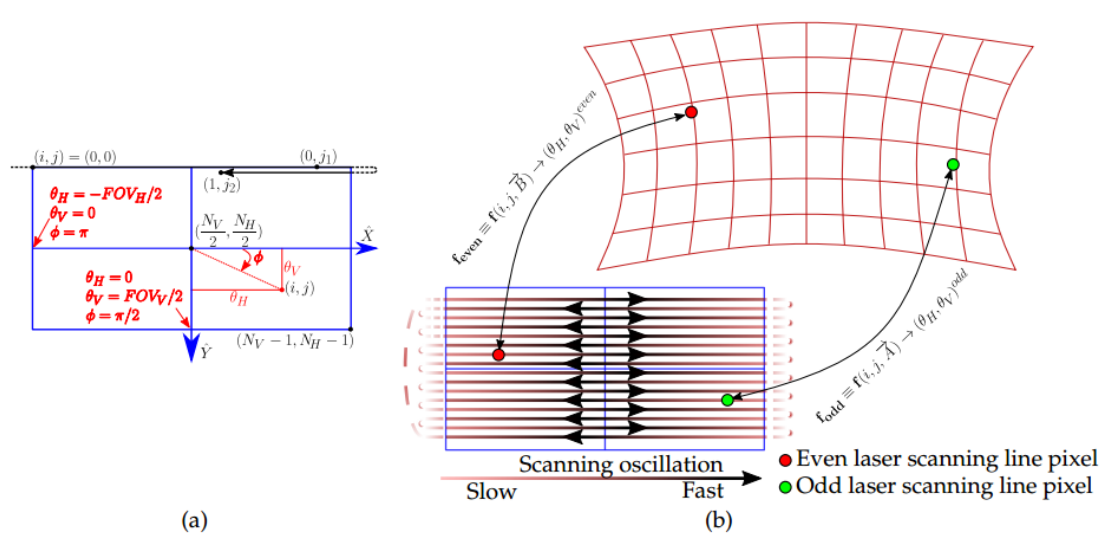
Figure 3. ( a ) Scheme of the LiDAR’s acquisition frame showing the relation between ( black ) the pixel position ( i , j ) from the MEMS dynamics and ( red ) the scanning angles of the FOV. ( b ) Scheme of the distortion mapping functions for odd and even lines, f odd and f even , relating the pixel position within the acquisition frame with the final scanning